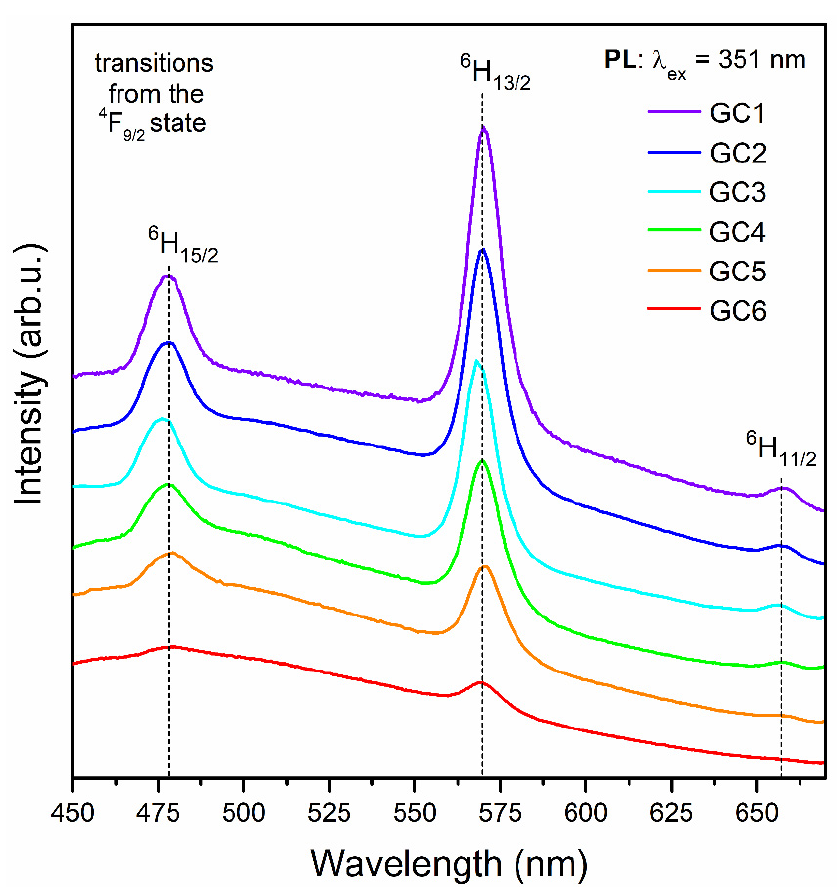
Figure 8. The photoluminescence emission (PL) spectra recorded for the series of prepared SiO 2